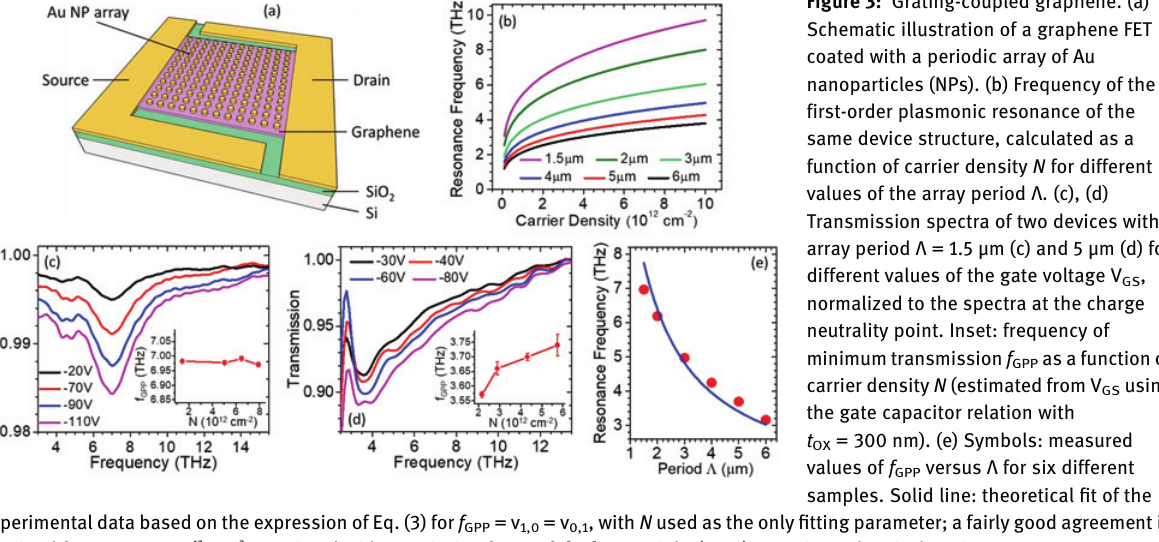
experimental data based on the expression of Eq. (3) for f GPP = ν 1,0 = ν 0,1 , with N used as the only fi tting parameter; a fairly good agreement is obtained for N = 4.1 × 10 12 cm − 2 . Reprinted with permission from ref. [56]. Copyright (2017), American Chemical